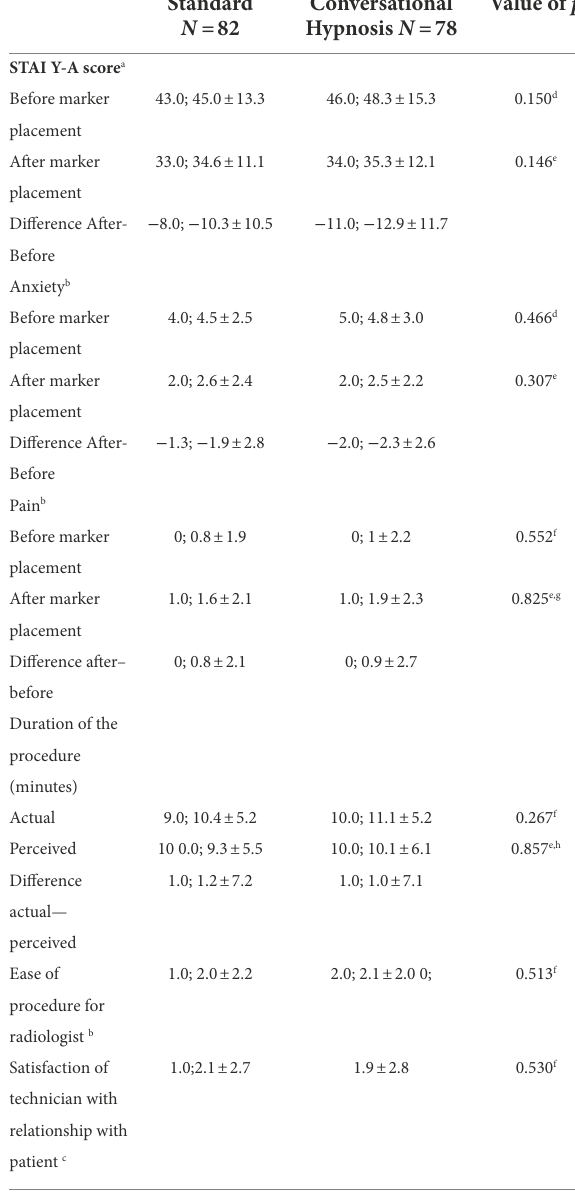
TABLE 2 Comparison of anxiety, pain, perceived duration of the procedure, ease of insertion of the marker as reported by the radiologist, and satisfaction of the technician with their relationship with the patient, according to randomization group.